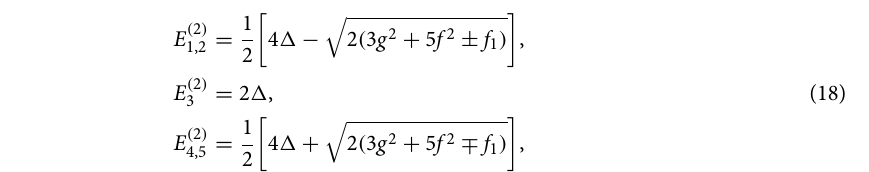
Figure 7. ( a – d ) Delay-time second-order correlation functions g mode a , the QD mode b , and the hybrid mode c modes in the QD-driven system assuming that g /κ max is equal to: ( a ) 3, ( b ) 2.1, ( c ) 3.8, and ( d ) 2.2. The four different predictions of correlations for the QD mode b correspond to all the cases listed in Table 2. ( e , f ) Same as in Fig. 4, but for the parameters given in Eq. (30). Note that